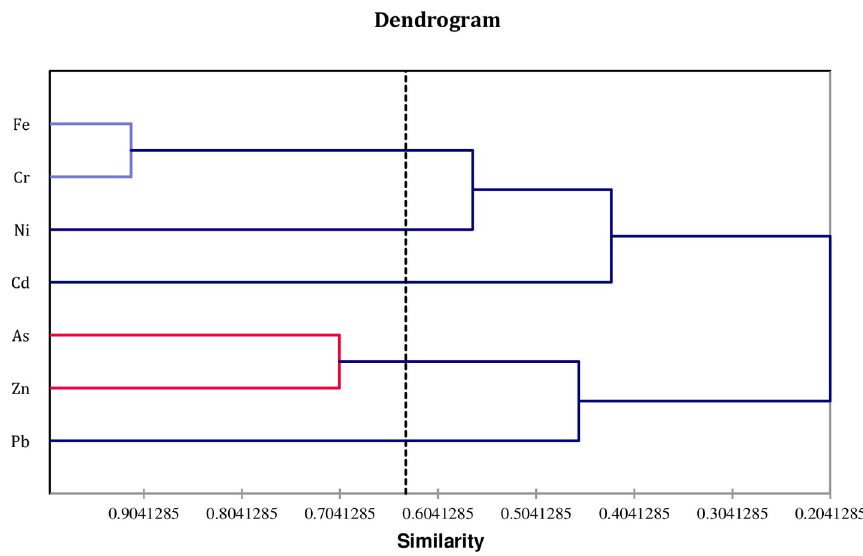
Fig 4. Hierarchical clustering analysis (Ward’s Method) showing the relevant association among heavy metals of sediment samples. (Distance metrics are based on the Euclidean distance single linkage method (proximity matrix). https://doi.org/10.1371/journal.pone.0263279.g004 statistically significant carcinogenic lifetime risk to adults, children, and kids, owing to the landfill leachate’s ability to bioaccumulate and be distributed predominantly through the sur- rounding soils into the groundwater. In the case of adults, children, and kids, the incremental lifetime cancer rate (ILCR) values were within the tolerable range of 1.00E-06–1.00E-04. The lifetime carcinogenicity risks associated with oral ingestion exposure to heavy metals were 9.09E-05 for kids, but 1.21E-05 and 3.60 E-05 for adults and children, respectively. Further- more, the mean cumulative risk values for dermal exposures were 3.24E-07, 1.89E-06, and 1.17E-05 for adults, children, and kids, respectively. The findings highlight the potential